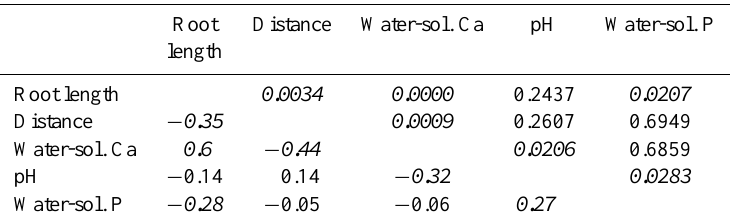
Table 3. Pearson correlation coefficients (lower part of the table) and p-values (upper part of the table) for root length density, distance from the stem, water-soluble Ca, pH and water-soluble P on the experimental site (ES). The numbers in italic indicate significant correlation between the respective variables ( p < 0 . 05).